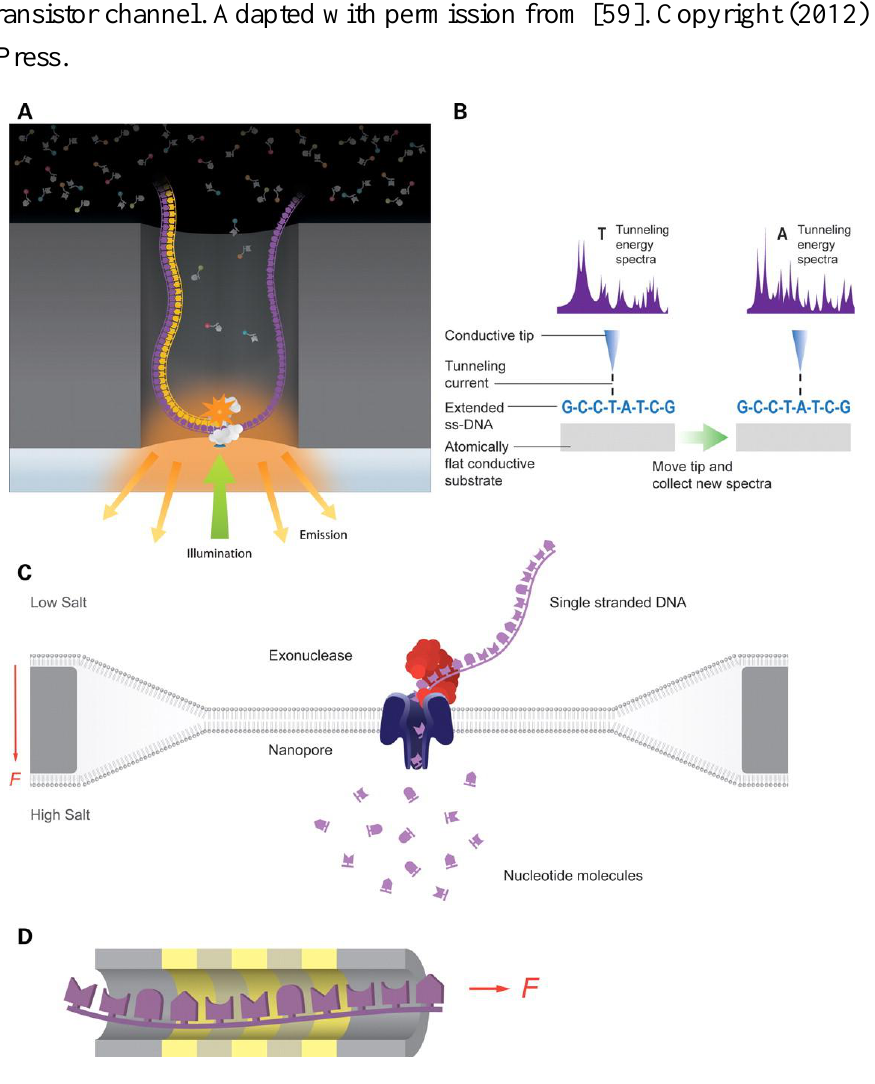
Figure 2. Third generation sequencing technologies. ( a ) Pacific biosciences technology, a DNA polymerase performs the synthesis while the base additions are detected